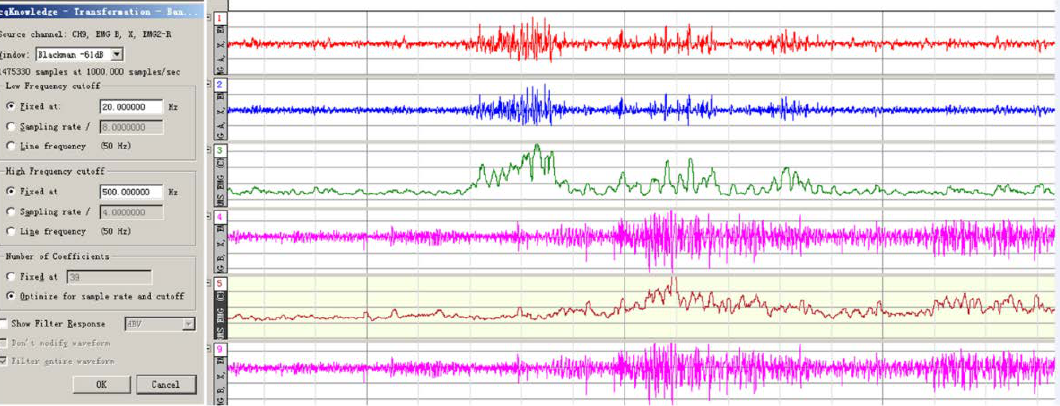
Figure 4. Comparison of the sEMG signal before and after processing. The first and sixth lines are the original EMG signal, the second and fourth lines are the filtered signal, and the third and fifth lines are the root mean square of the EMG signal.